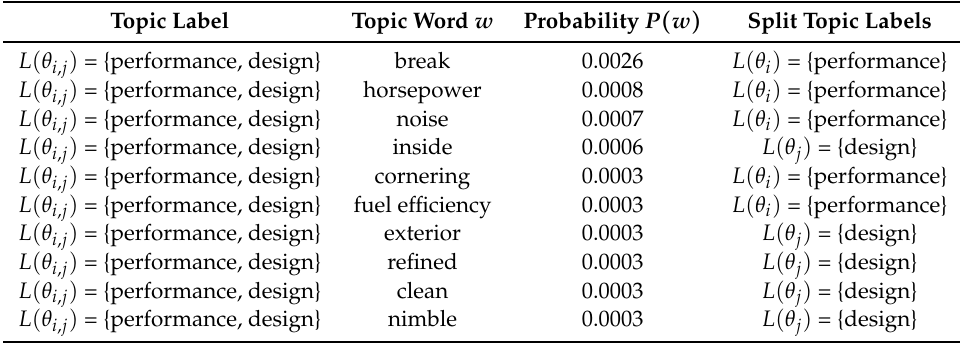
Table 1. An example of the topic split problem— L ( θ i , j ) = {performance, design}.